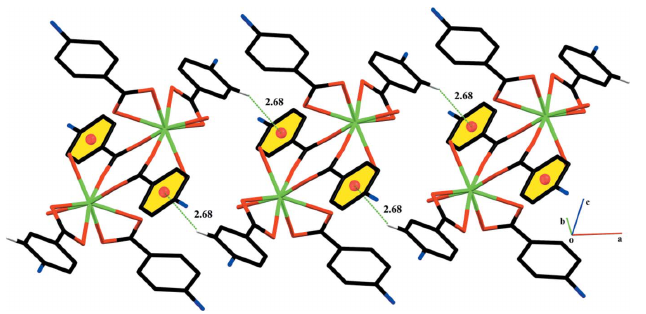
Figure 3 Graphical representation of C—H (cid:2)(cid:2)(cid:2) (cid:2) interactions in 4ABA-Tm . Selected H atoms are shown while the water molecules are omitted for clarity.